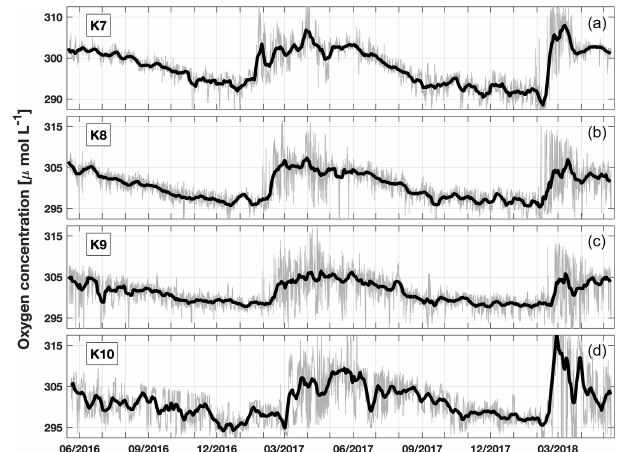
Figure 4. Time series of oxygen concentration at 610m for K7, K8, K9, and K10 (a–d) . Gray lines show original 15min data, and black lines show time series filtered with a 10d running mean. Note that axis limits are 5µmolL − 1 lower in (a) , but the range is the same for all